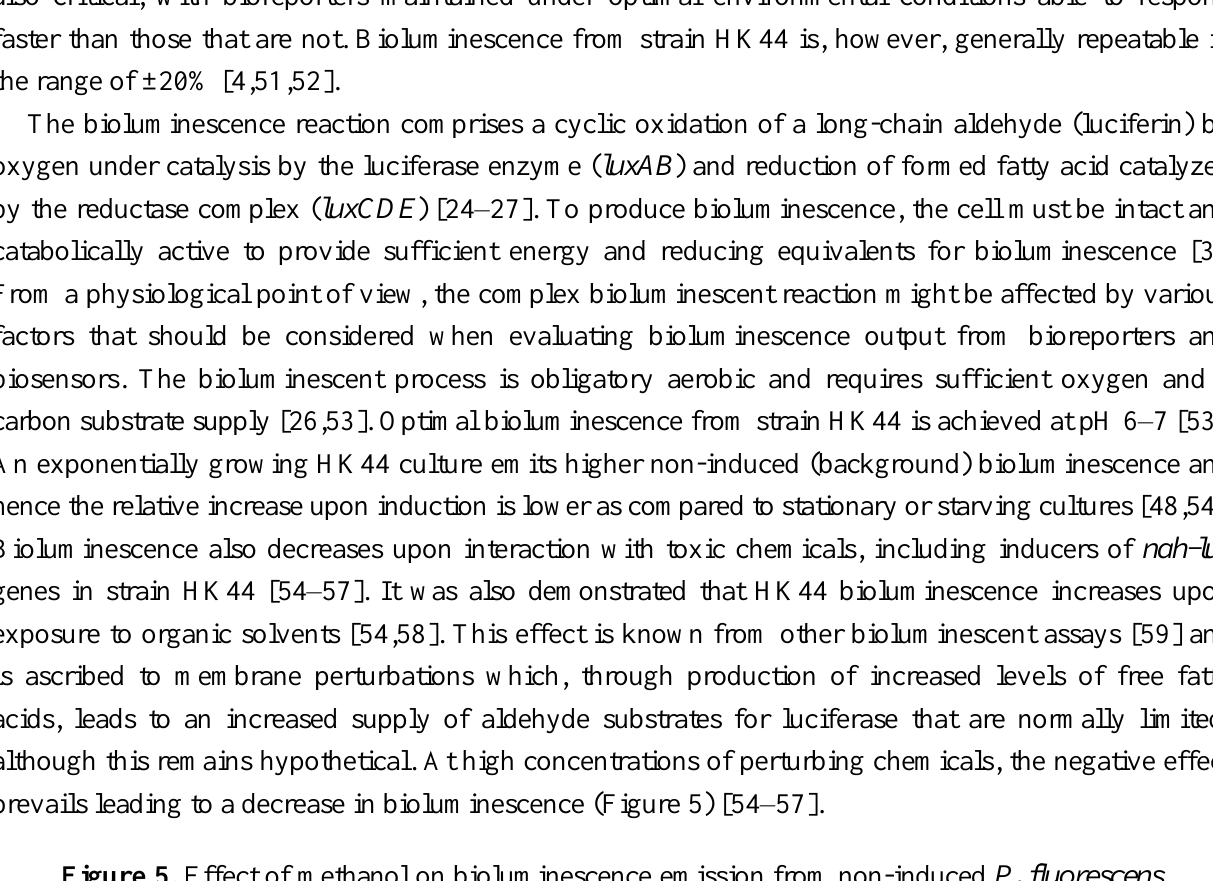
Figure 5. Effect of methanol on bioluminescence emission from non-induced P. fluorescens HK44. Values are expressed relative to a control not exposed to methanol. Reprinted from [38] with